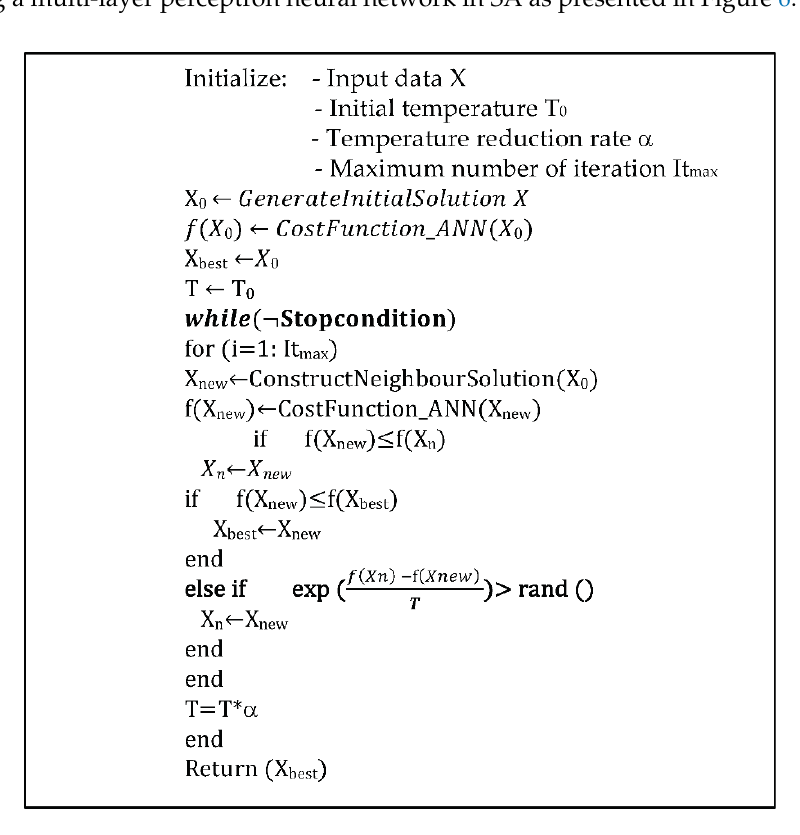
Figure 6. Pseudo code for hybrid simulated annealing.